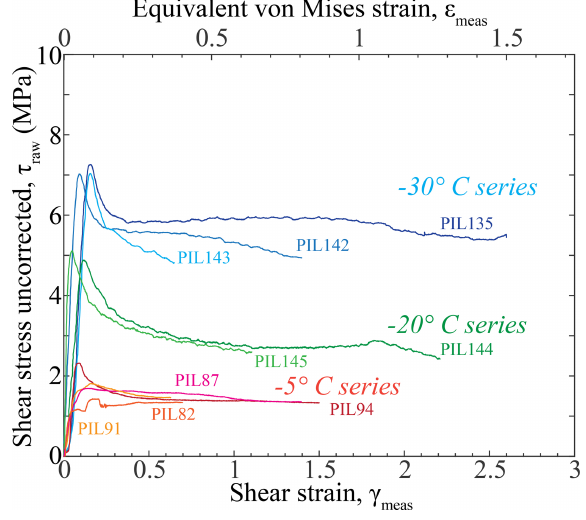
Figure 3. Plots of stress–strain curves for all experimental runs. The y axis is the shear stress, τ raw , calculated from the axial load. No correction has been applied for the change of sample area with strain. The bottom x axis is shear strain and the top x axis is von √ Mises equivalent strain, ε meas = γ meas /